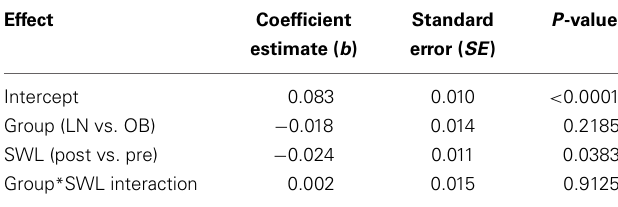
Table 3 | Mixed effects model on brachial artery FMD